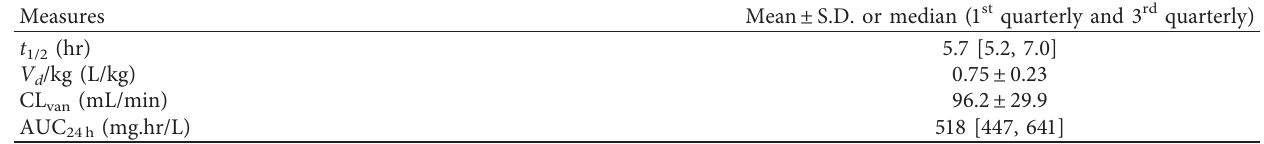
Table 1: Pharmacokinetic parameters of vancomycin.